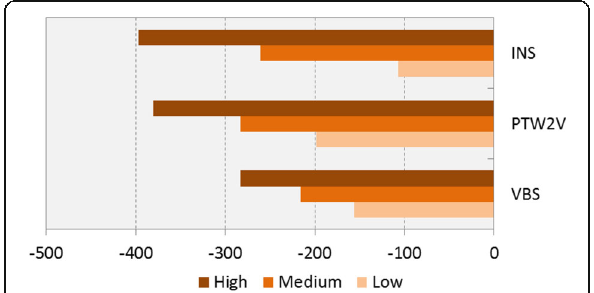
Fig. 4 The overall impact in number of PTW rider fatalities in the EU-28, full penetration. High/medium/low indicate the range of the estimate